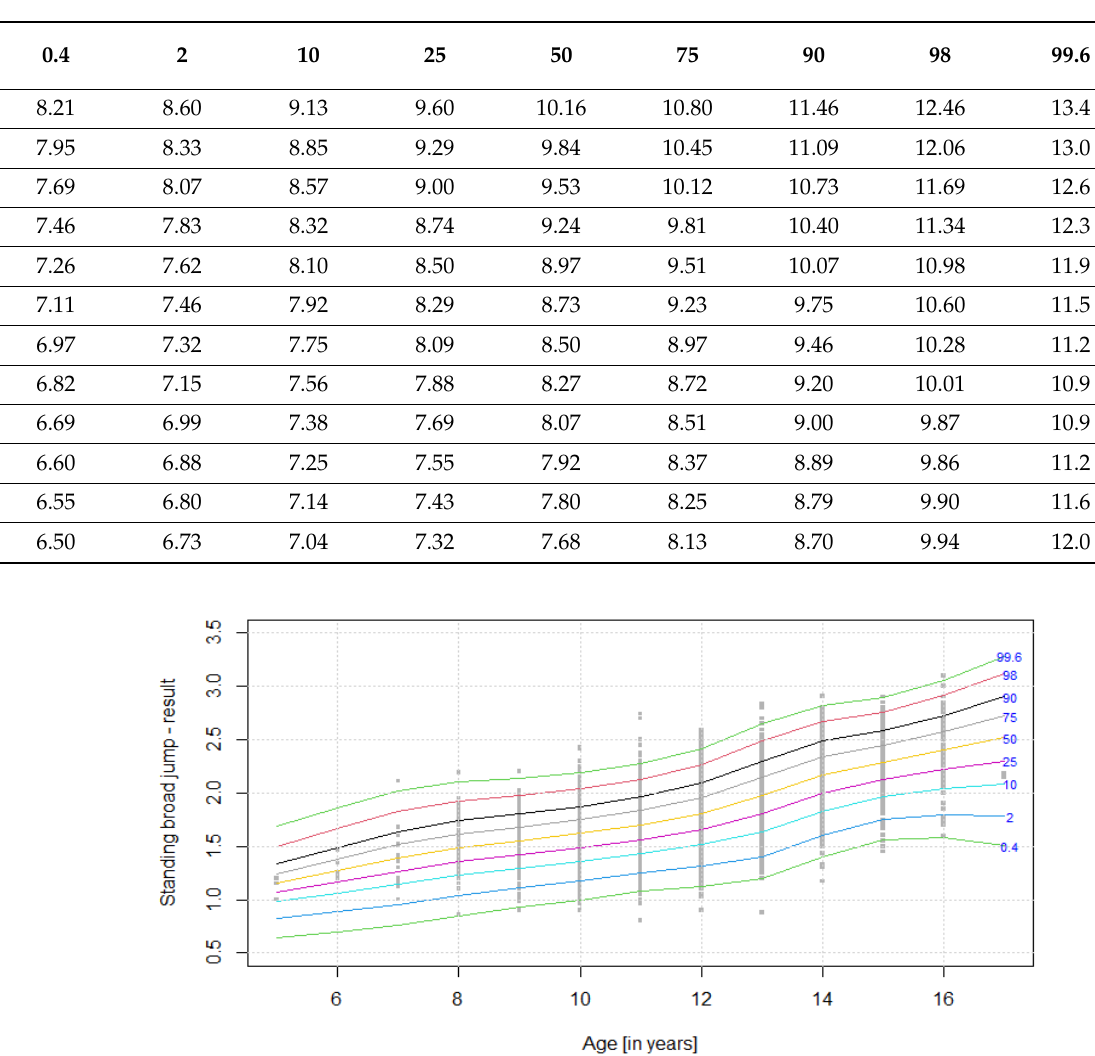
Figure 2. Centile chart for 3 × 10 m run in girls. Table 5. Values of particular centiles for 3 × 10 m run in girls.